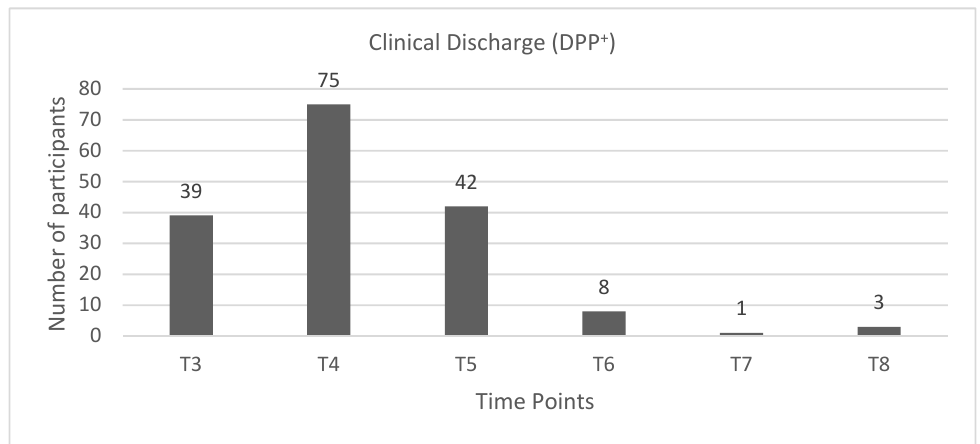
Figure 5. Graphic describing the number of DPP + dogs in the study group (SG) with clinical discharge